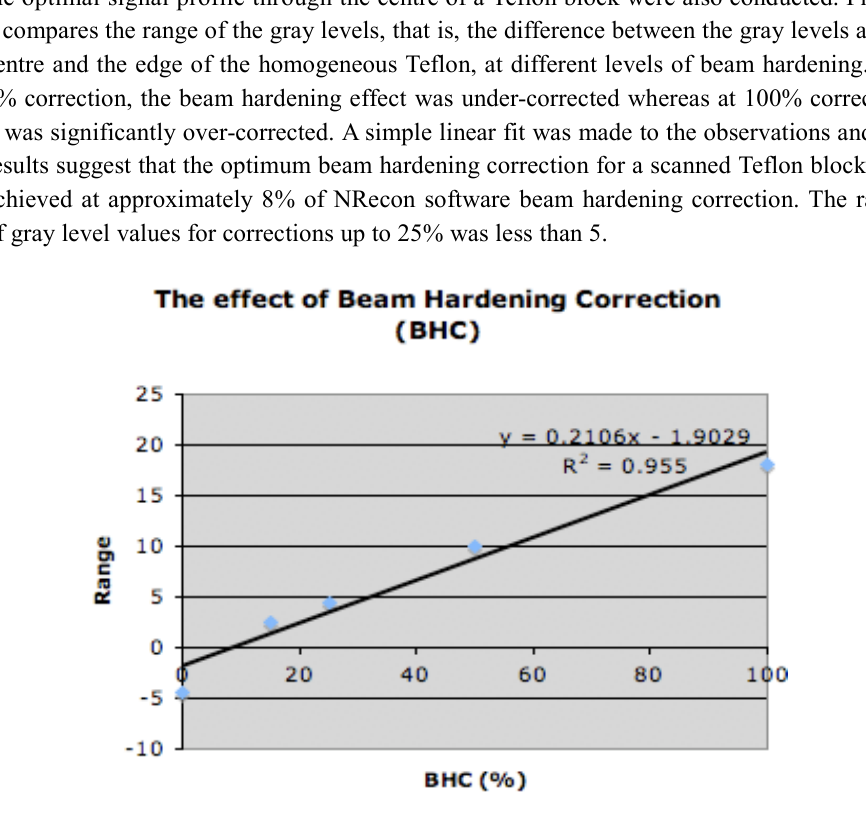
Figure 5. The effect of different beam-hardening corrections (BHC) using the SkyScan software algorithm - The least amount of beam hardening effect is predicted to be 8% of NRecon software BHC in the scanned Teflon